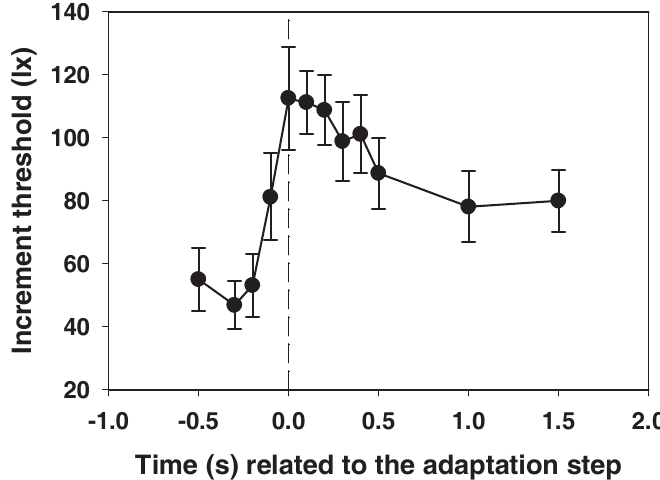
Figure 4. Time course of the electroretinographic increment threshold, averaged for all twelve test subjects, with standard deviations. Basic adaptation light 0.5 lx, adaptation light step 2.5